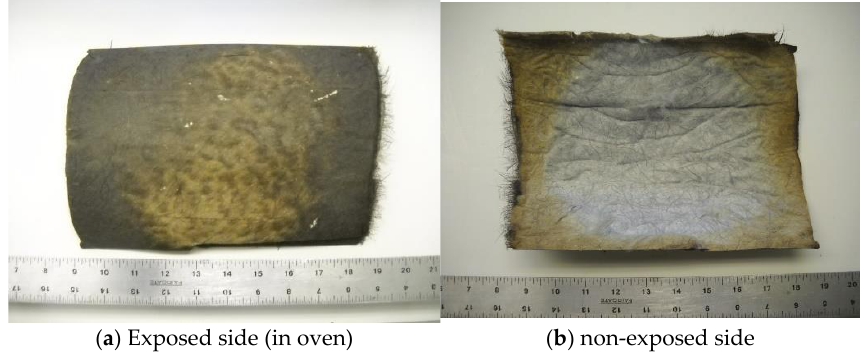
Figure 10. Heated preforms after compression molding.